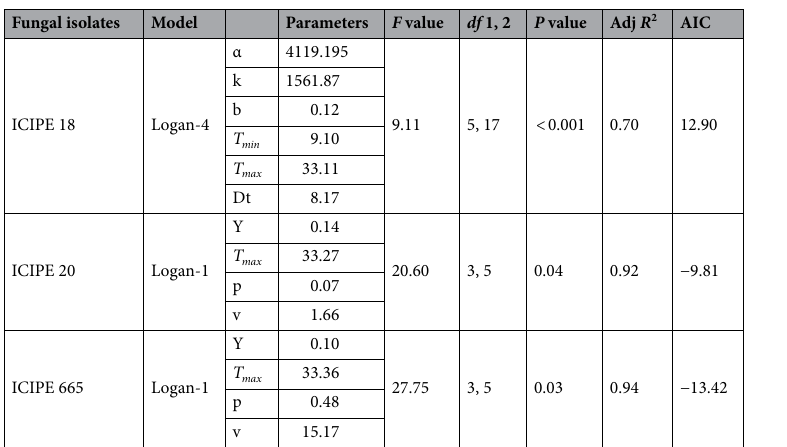
Figure 5. Observed and predicted mortality of adult Tuta absoluta by Metarhizium anisopliae isolates ICIPE 18, ICIPE 20 and ICIPE 665 in relation to temperature using the linear and nonlinear models. The blue dots on the graph represent the cumulative values of the proportion of adult Tuta absoluta that were killed by the three isolates during the experiments at the respective temperatures. The curve represents the Logan-4 and Logan-1 nonlinear models that best fits the experimental data points and were used to predict the level of efficacy of isolates ( A ) ICIPE 18, ( B ) ICIPE 20 and ( C ) ICIPE 665 against adult Tuta absoluta . Fitted models are the dashed straight lines for linear regression and solid lines for the Logan models. Dashed lines above and below represent the upper and lower 95% confidence interval (n = 60; N = 4; Tukey’s HSD test).